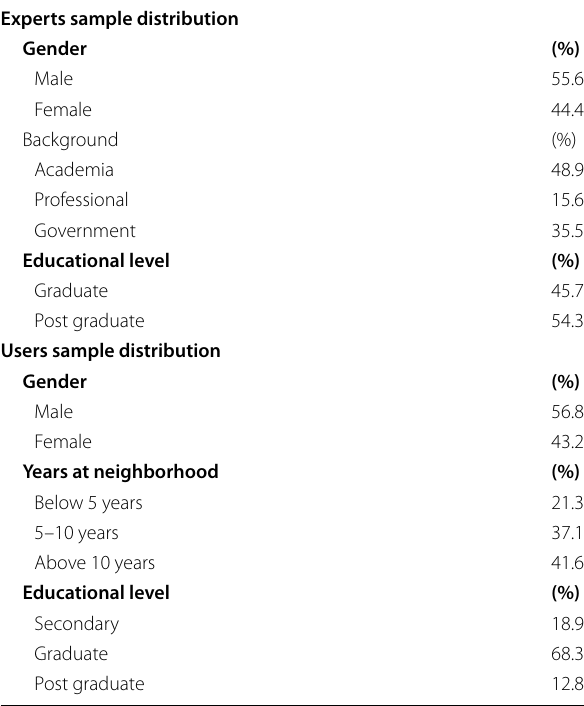
Table 1 Distribution of the panel involved from the experts and